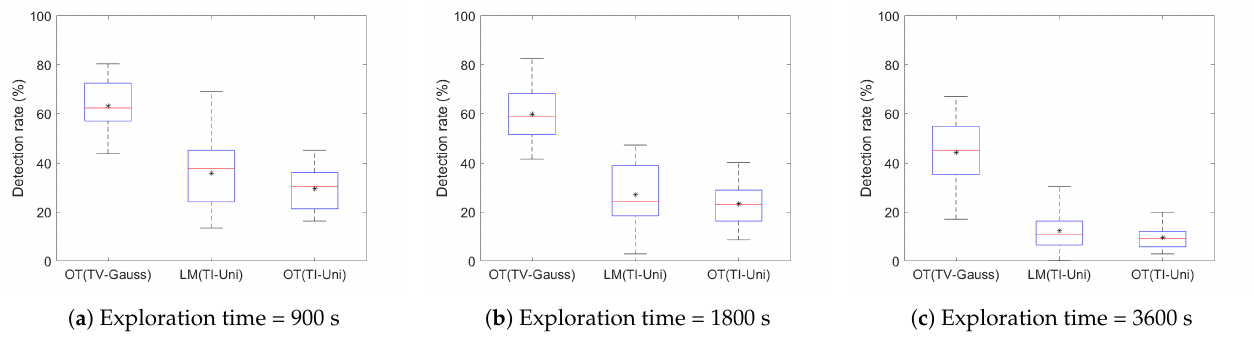
Figure 9. Statistical data for the performance comparison among OT (TV-Gauss), LM (TI-Uni) and OT (TI-Uni) with 600 s delay and 3 agents: boxplots for target detection rates for ( a ) exploration time = 900 s; ( b ) exploration time = 1800 s; and ( c ) exploration time = 3600 s. Mean values for the boxplots are indicated by asterisk